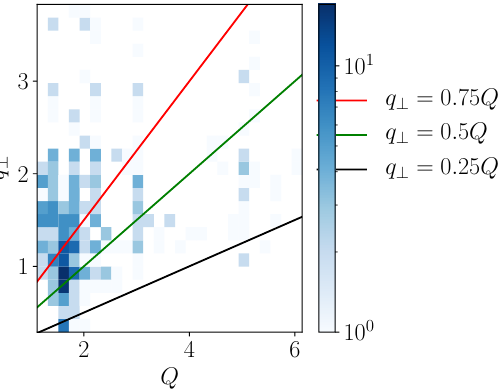
Figure 6 . Histogram of the SIDIS data in q ⊥ and Q . To obtain this plot, we bin the SIDIS data sets in q ⊥ and Q . The dark spots indicate a large number of experimental data while the white spots indicate that there are no experimental data. We also plot the line q ⊥ = 0 . 75 Q in red, 0 . 5 Q in green, and 0 . 25 Q in